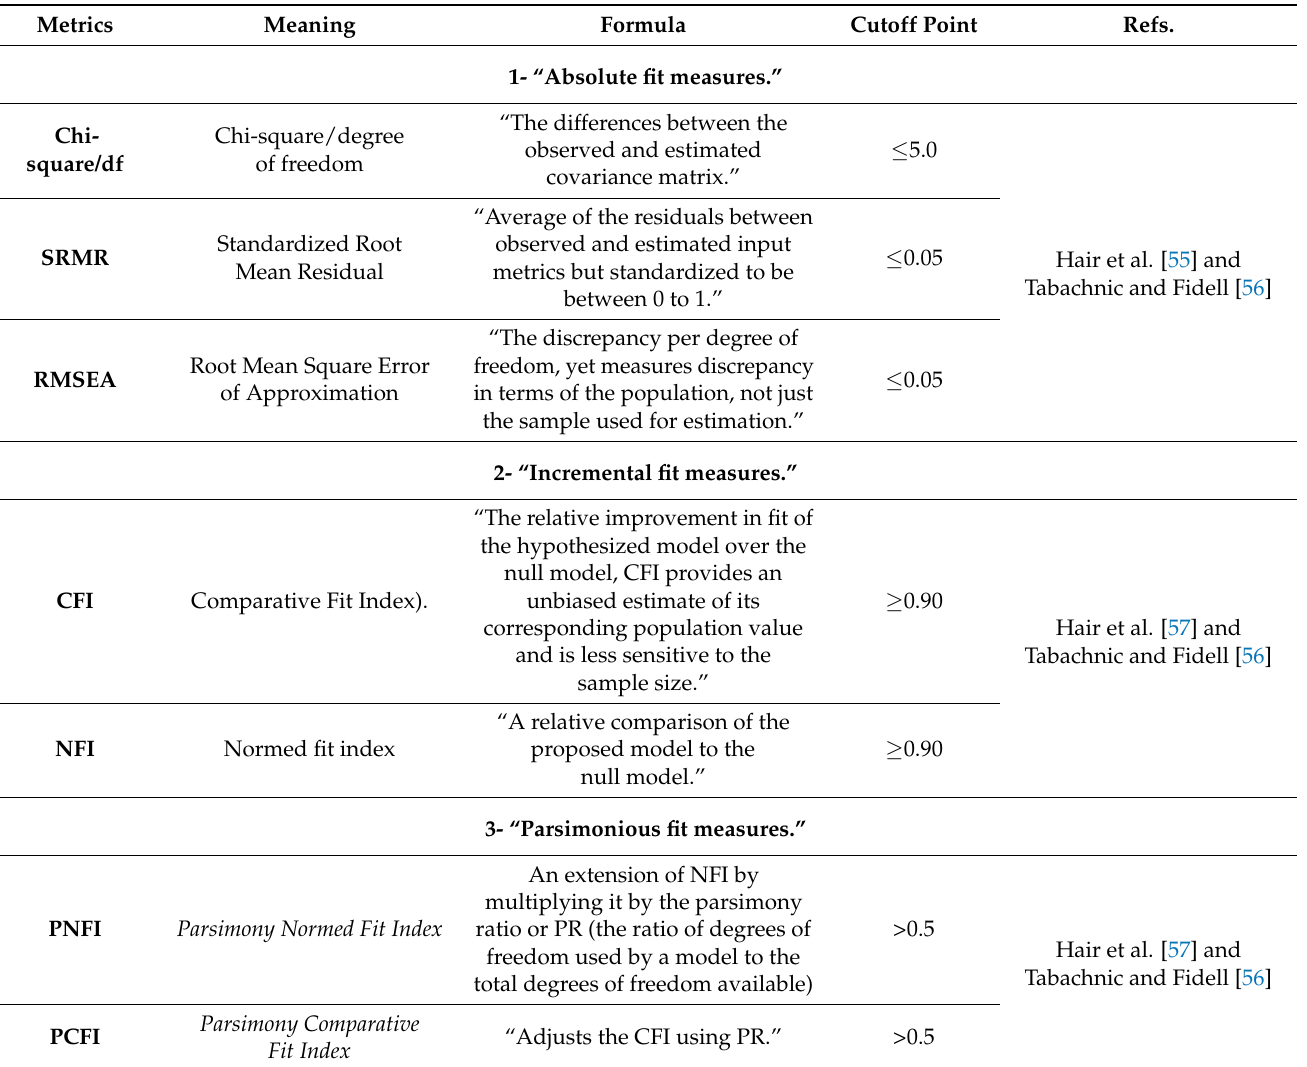
Table 1. SEM GoF